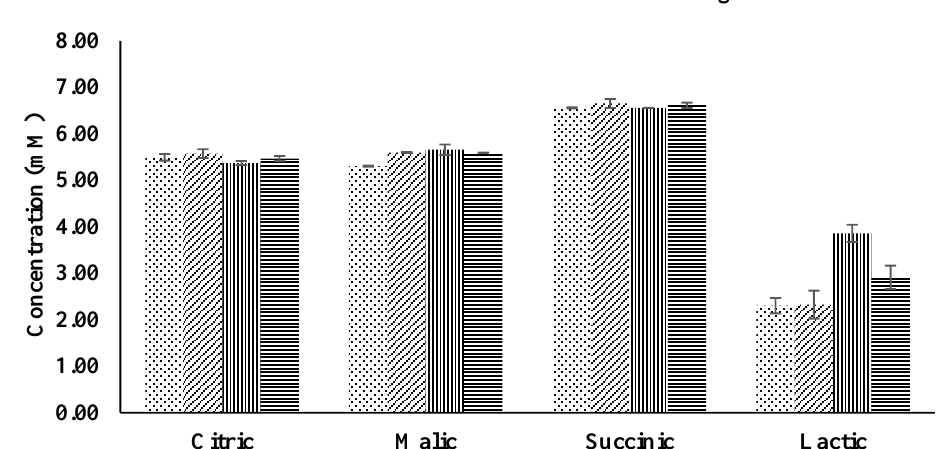
Figure 3. Concentration of the different organic acids secreted by the roots of the different rice cultivars in solution culture.